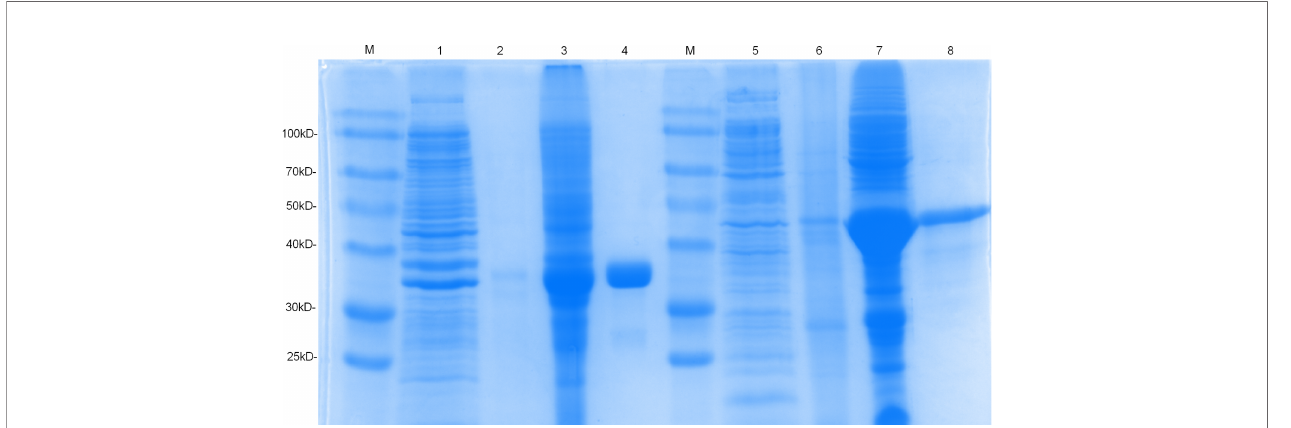
FIGURE 2 | SDS-PAGE analysis of the puri fi cation and expression of recombinant protein Rv1566c-444 and Rv1566c. Lane M, Prestained protein marker; Lane 1, the uninduced pET32a-Rv1566c-444 transformed E. coli ; Lanes 2 and 3, the supernatant and sediment of the induced pET32a-Rv1566c-444 after ultrasonication and centrifugation; Lanes 4: puri fi ed recombinant protein Rv1566c-444; Lanes 5, the uninduced pET32a-Rv1566c transformed E. coli ; Lanes 6 and 7, the supernatant and sediment of the induced pET32a-Rv1566c after ultrasonication and centrifugation; Lanes 8: puri fi ed recombinant protein